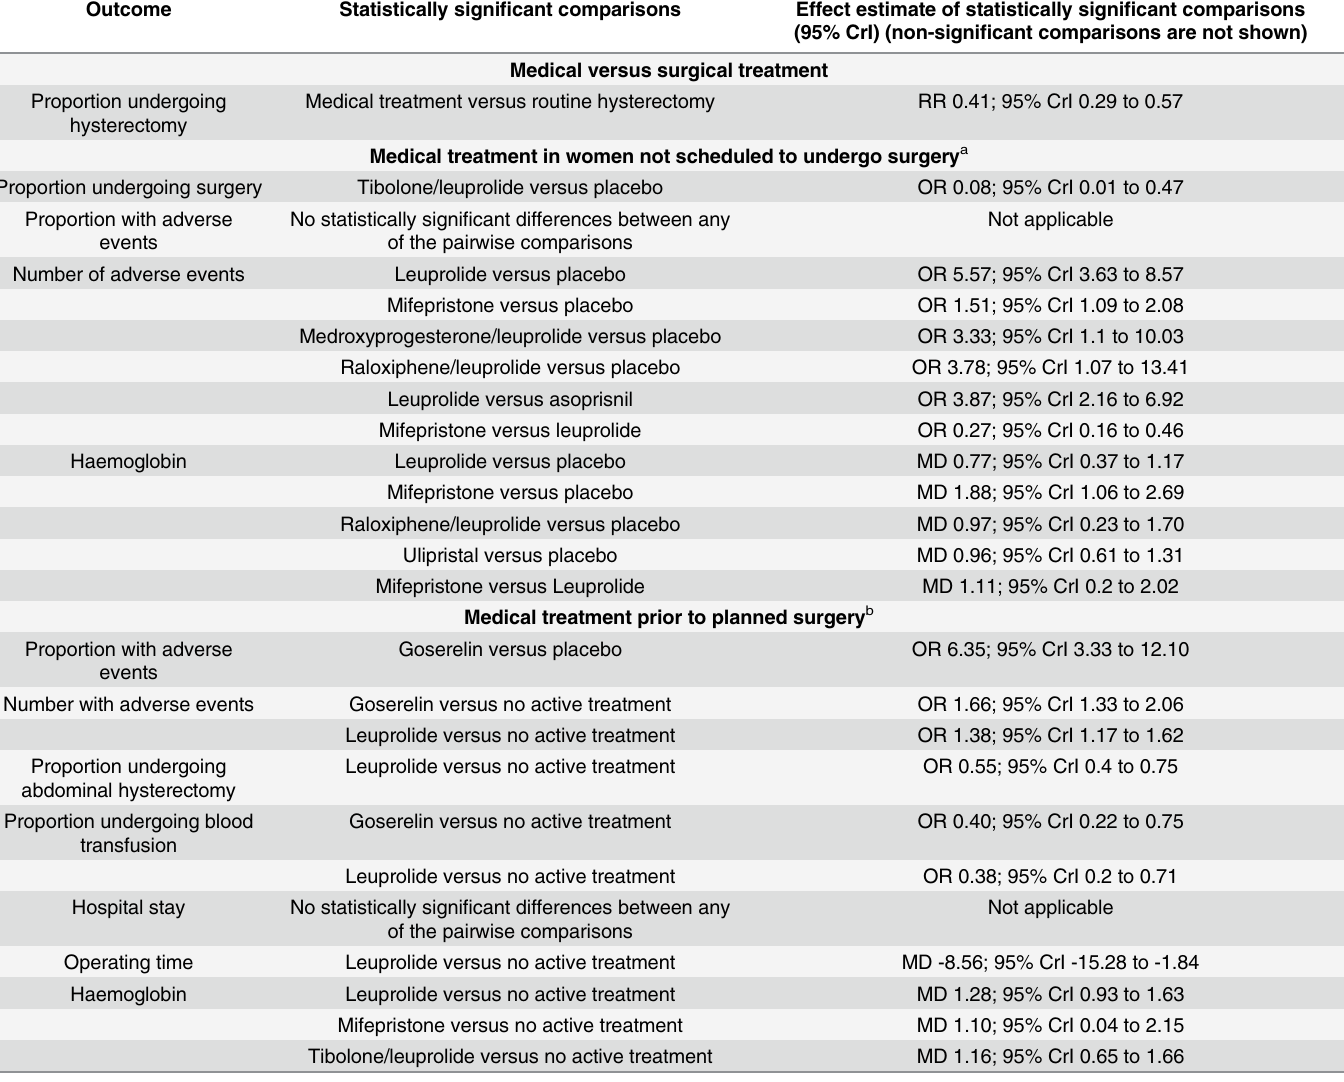
Table 1. Summary of